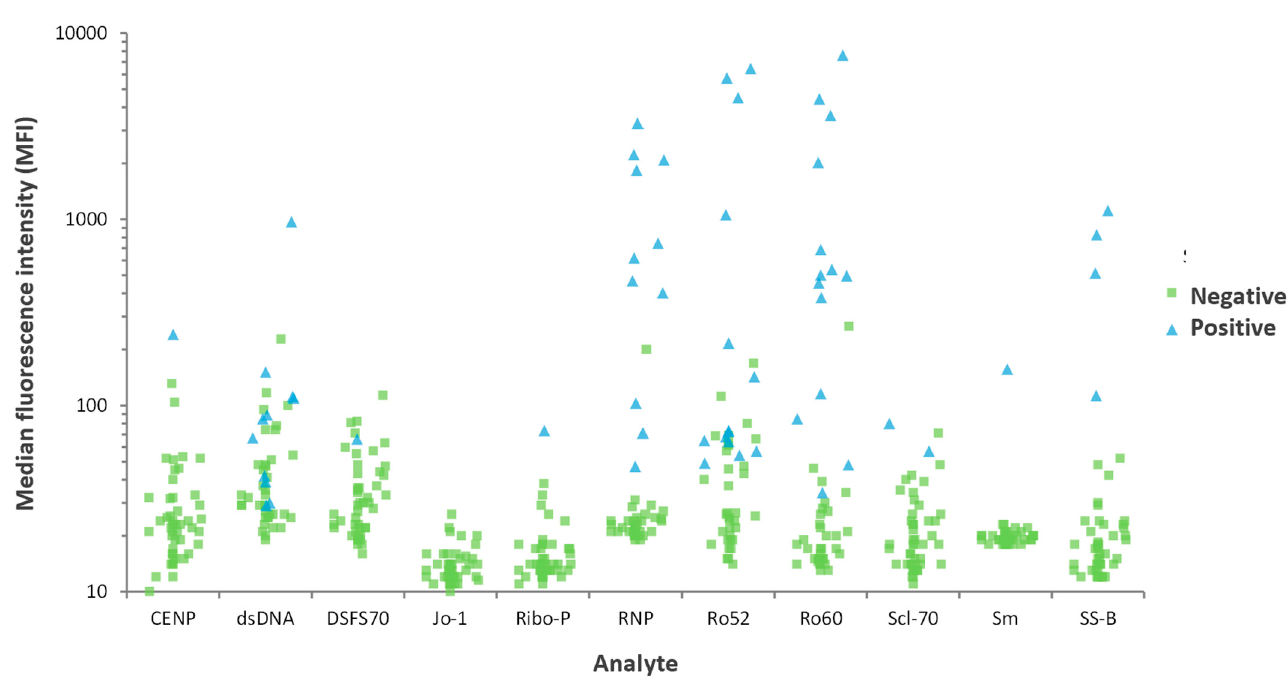
Figure 1. Scatter plot of autoantibodies measured in saliva samples stratified by antibody specificity. Patients are color coded based on the autoantibody status (antibodies to dsDNA, RNP, Sm, Ro52, Ro60, SS-B, CENP, Scl-70, Ribo-P, Jo-1, and DFS70) as defined using the serum sample (green = negative; blue = positive).